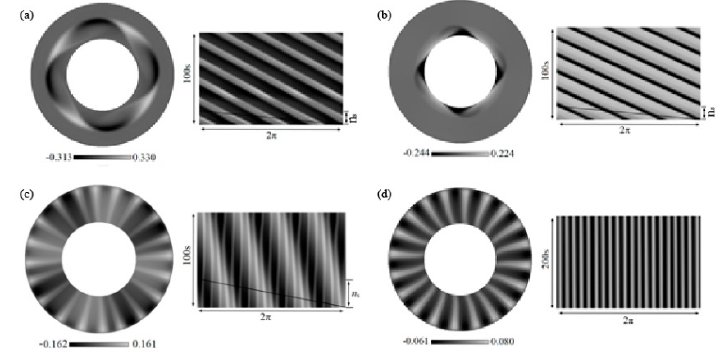
Figure 11. Snapshots of the surface concentration (left) and the corresponding STD at R = 0.55 (right) when Re s = 935. ( a ) Re T = 4.0 × 10 2 ;( b ) Re T = 2.2 × 10 3 ; ( c ) Re T = 3.0 × 10 3 ; ( d ) Re T = 6.0 × 10 3 .